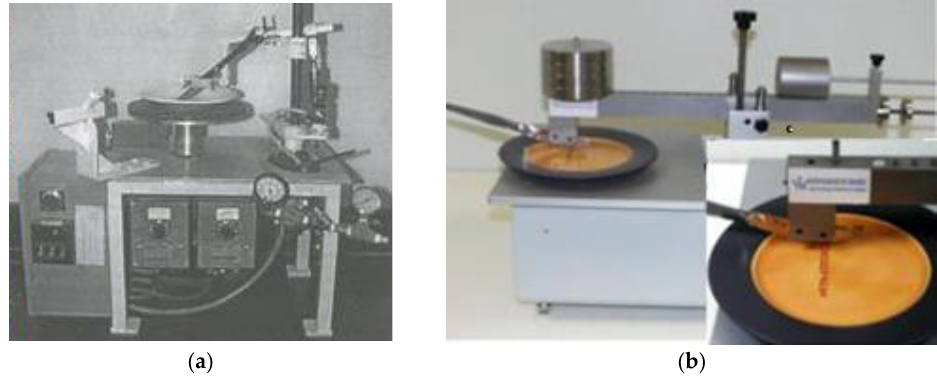
Figure 7. Examples of metal marking apparatus used by some research centers ( a ) NYSCC — New